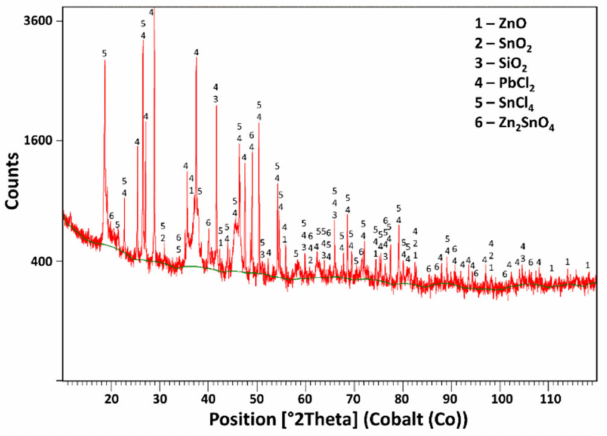
Figure 3. X-ray diffraction phase analysis (XRD) analysis of Copper Anode Furnace dust [10]. SEM-EDX semiquantitative analysis (Figure 4) identified 15.5% content of O and 15.1% of Cl, which confirms presence of oxide phases and chloride phases in the sample.